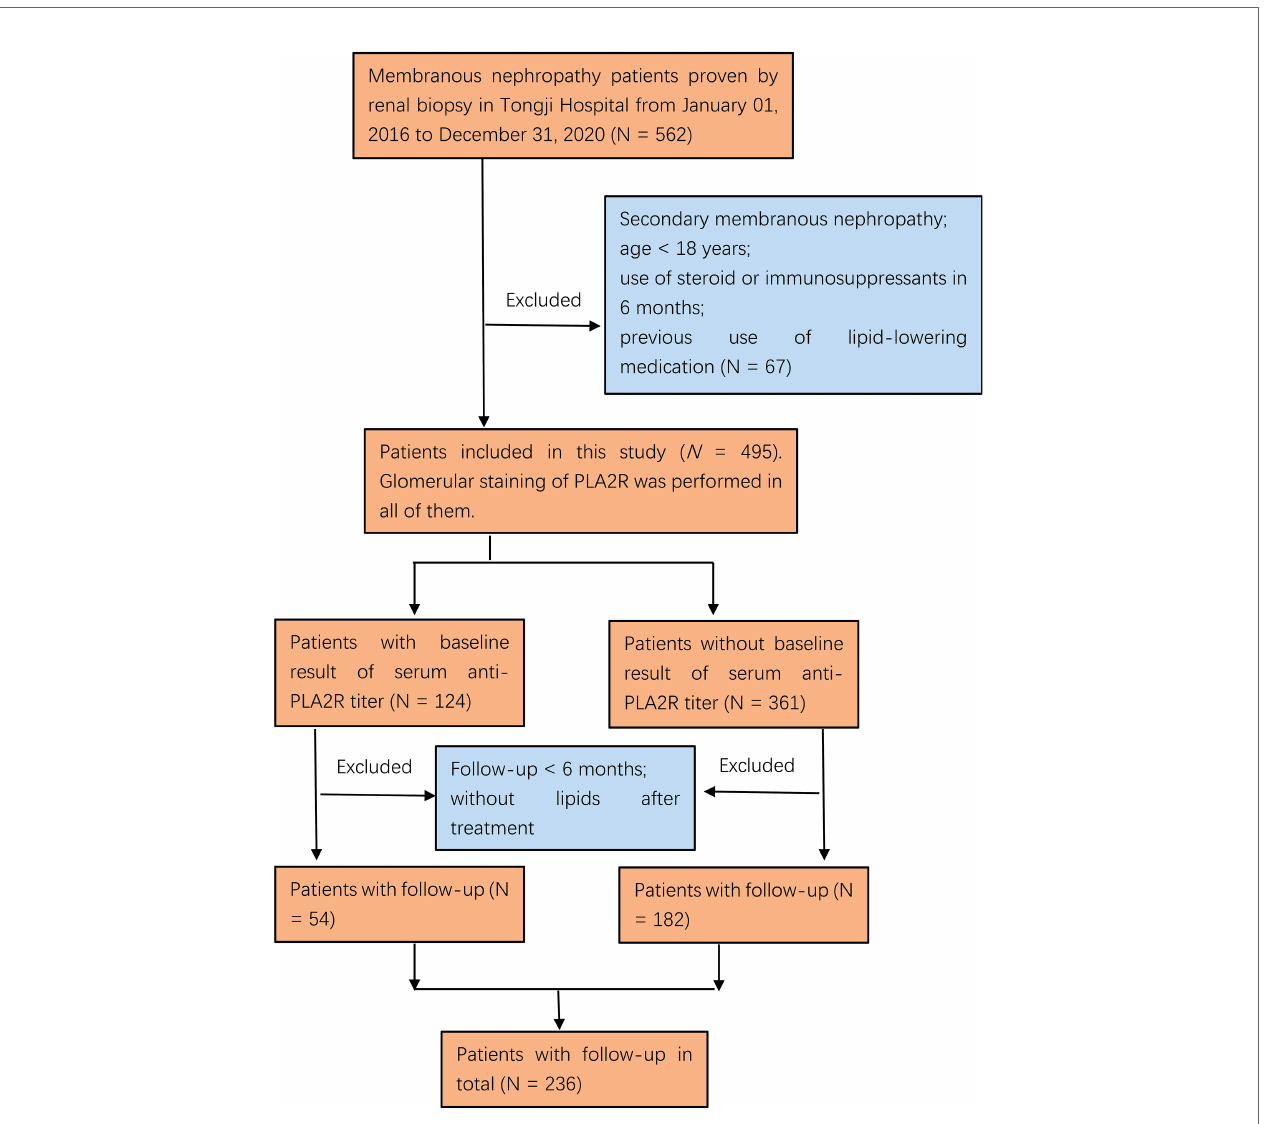
FIGURE 1 | Flowchart of participant selection in this study. Among 562 membranous nephropathy patients, 495 who met the inclusion criteria were included. One hundred twenty-four of 495 participants had been examined for the serum anti-PLA2R antibody at onset, and 236/495 had longitudinal data with follow-up for >6